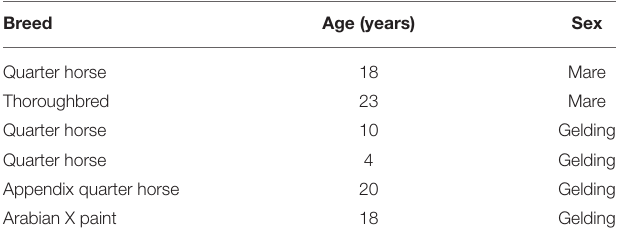
TABLE 1 | The breed, age, and sex of each horse included in the study. Breed Age (years) Sex Quarter horse 18 Mare Thoroughbred 23 Mare Quarter horse 10 Gelding Quarter horse